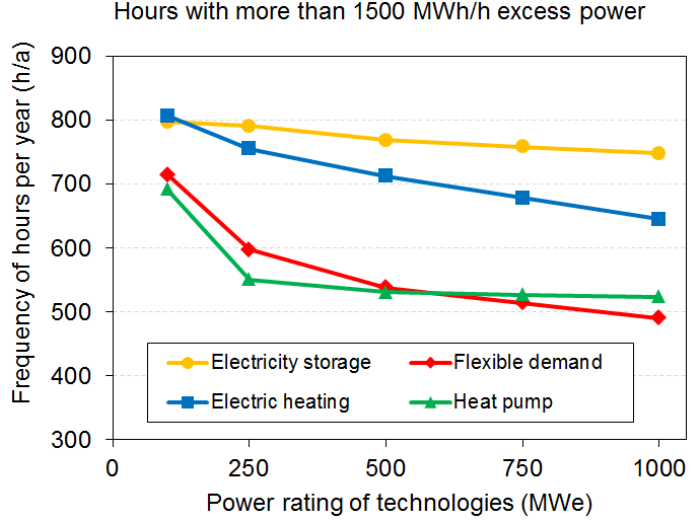
Figure 17. Performance of flexibility solutions in different power ratings in decreasing the frequency of the hours with power